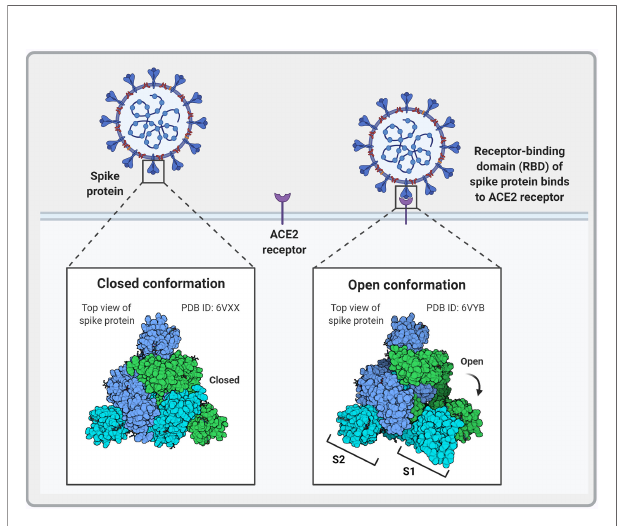
FIGURE 3 | Schematic representation of the different conformational states of the SARS-CoV-2 spike protein. When in the closed conformation, the receptor binding domain (RBD) and its epitopes are hidden thereby contributing to immune evasion. In contrast, when subunit 1 (S1) dissociates from subunit 2 (S2) an open conformation is achieved that exposes the spike protein RBD and allows interaction with the host angiotensin-converting enzyme 2 (ACE2) to facilitate viral entry. Image created by PM using BioRender